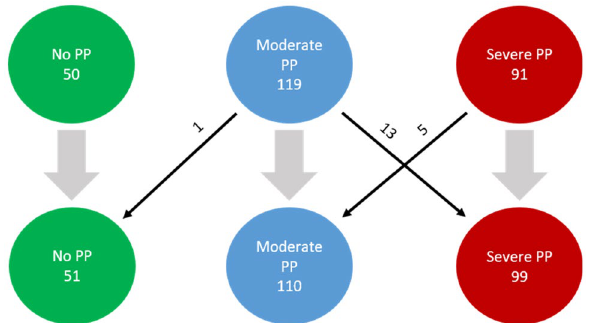
Figure 8. Rearrangement within ‘non-PP’ and ‘PP’